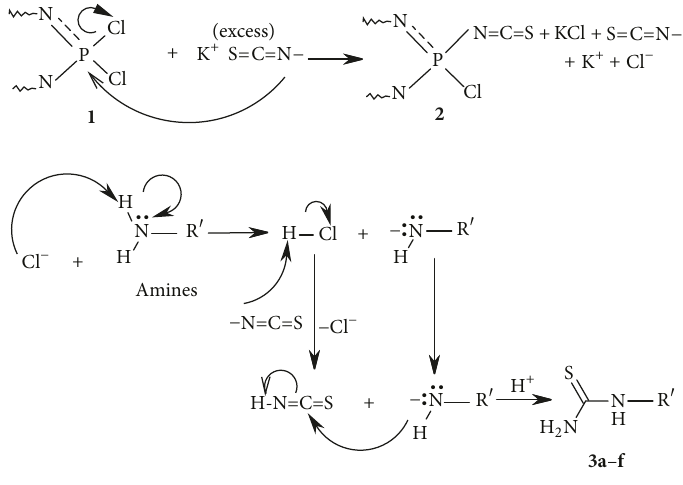
Scheme 2: Mechanism on the formation of 3a – f .